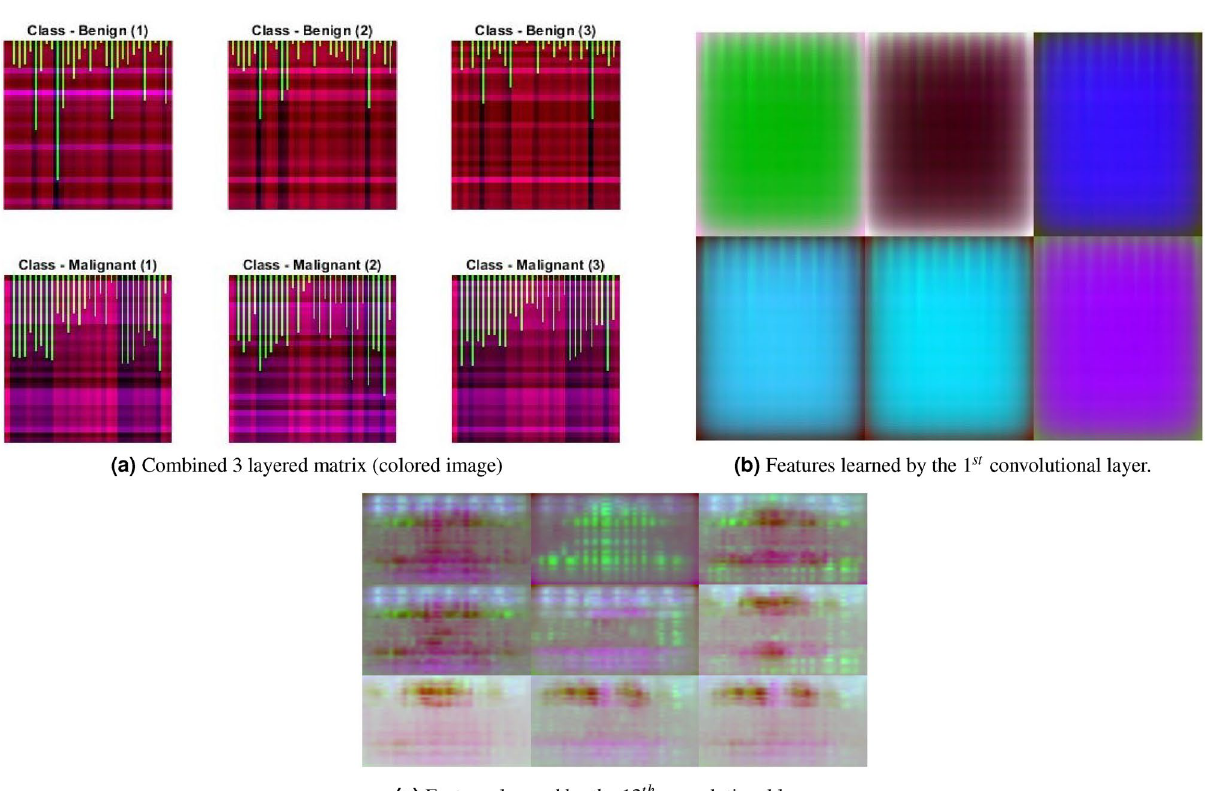
Figure 5. Combined transformation technique and its corresponding convolution with CNN for some data examples of WDBC